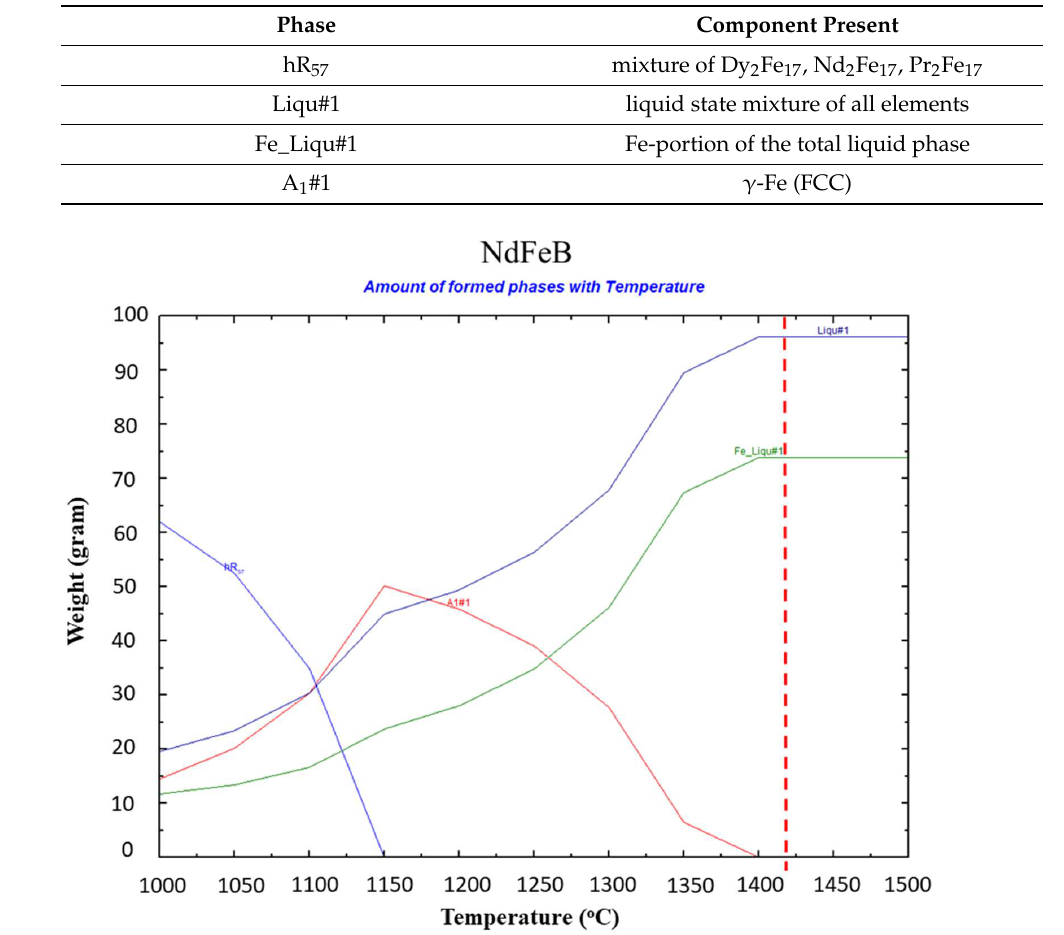
Figure 3 . Number of formed phases with a temperature of NdFeB from 1000–1500 °C . Figure 3. Number of formed phases with a temperature of NdFeB from 1000–1500